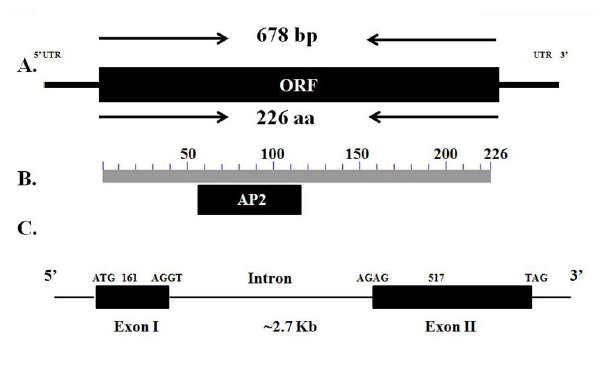
Figure 2. Structure of the JnRAP2-like . A . The full-length coding sequence of JnRAP2-like is 678 bp, starting with ATG and ending with TAG. B . The location of the AP2 domain. C